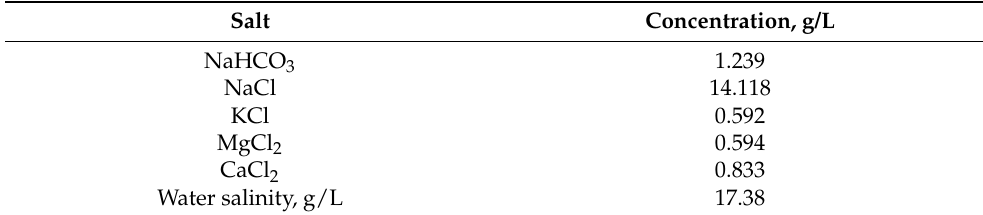
Table 1. Brine composition for this study.